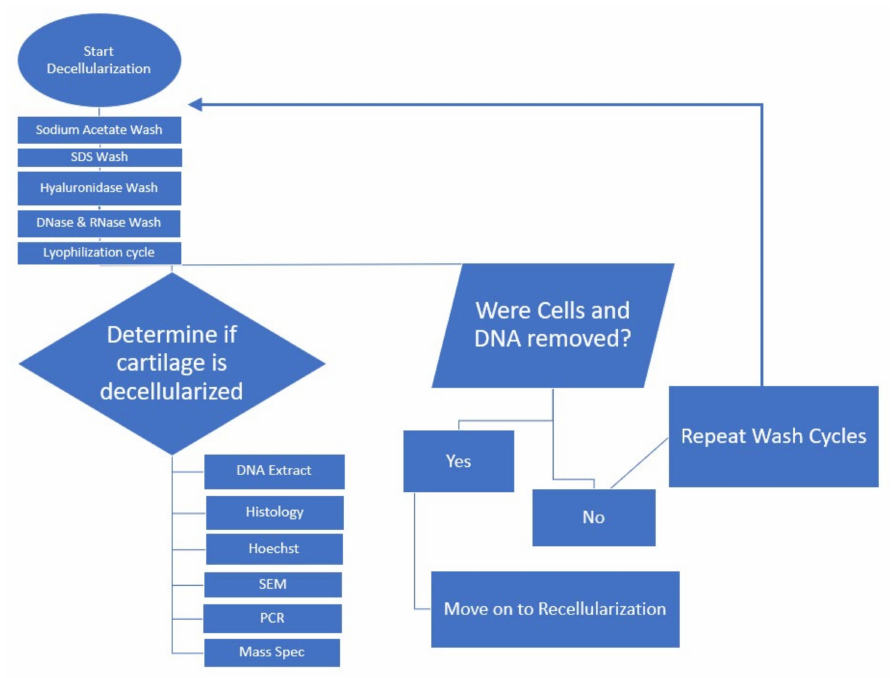
Figure 2. Flowchart for decellularization